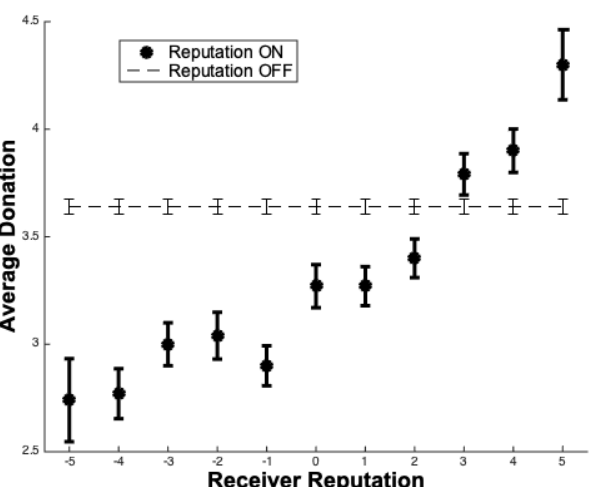
Figure 3. Comparison between the average donation trend with respect to Receivers’ reputation scores (dots) and the amount offered without the reputation system (dashed line).